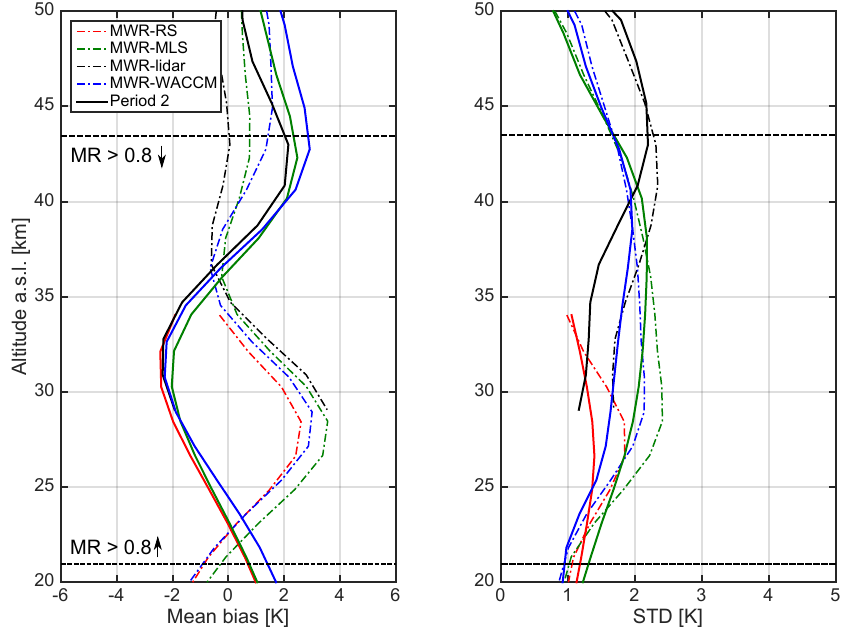
Figure 17. Mean and standard temperature deviations between the TEMPERA radiometer and the measurements from the different instru- ments and